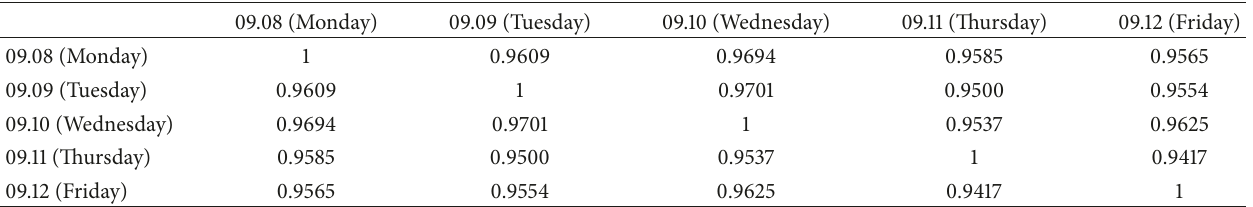
Table 6: Correlation coefficient matrices of two traffic volume series from the same detector located at urban expressway but in five consecutive working days.